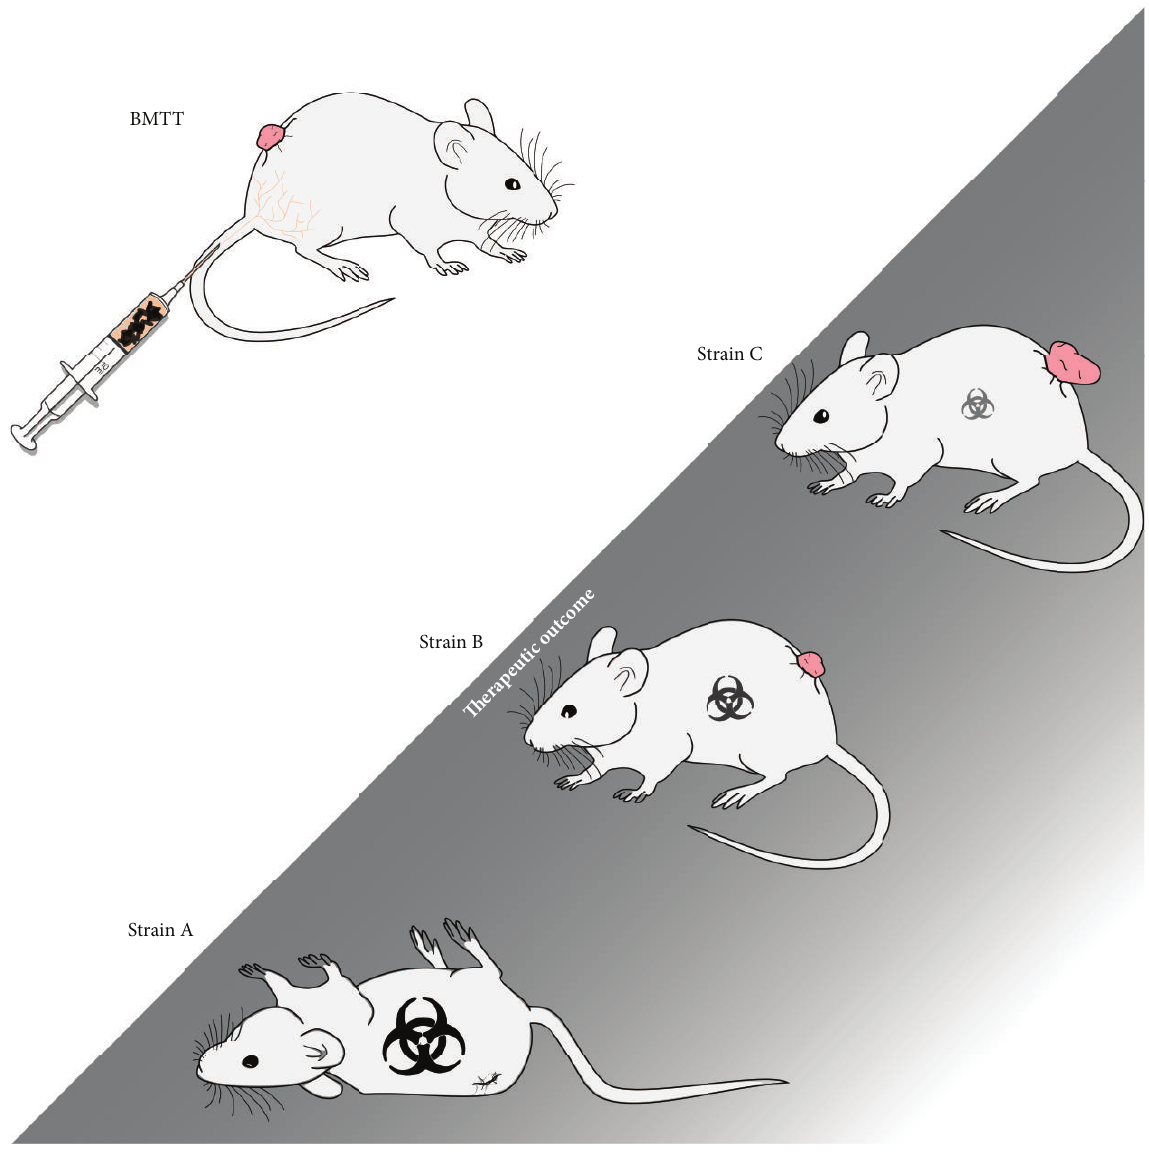
Figure 3: Various phenotypic outcomes in mice following treatment with Salmonella . The inverse relationship between intrinsic therapeutic benefit and safety of bacteria mediated tumor therapy (BMTT) using Salmonella can be demonstrated through manifestation and progression of cancer and infection in mice. An inadequately attenuated, thus virulent, strain may successfully retard/regress tumor development albeit concurrently resulting in morbidity and mortality of the patient (strain A). Conversely, overattenuation may ensure patient safety at the cost of therapeutic efficacy (strain C). Intermediate levels of attenuation may yield corresponding levels of cancer progression and manifestation of infection (strain B). Thus, developing a properly balanced strain remains a challenge for successful therapy using Salmonella .